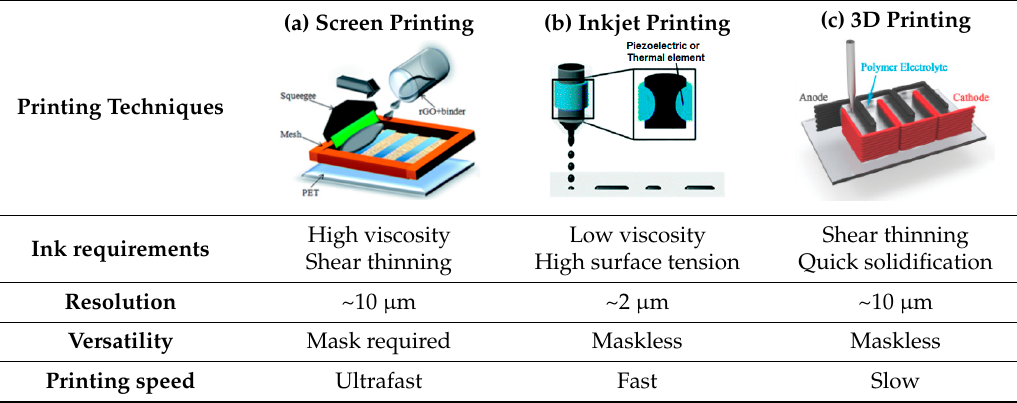
Table 2. The properties of different printing techniques. Inset: ( a ) Screen printing, reproduced with permission from Reference [115]. Copyright © 2014 The Royal Society of Chemistry. ( b ) Inkjet printing, reproduced with permission from Reference [117]. Copyright © 2018 The Royal Society of